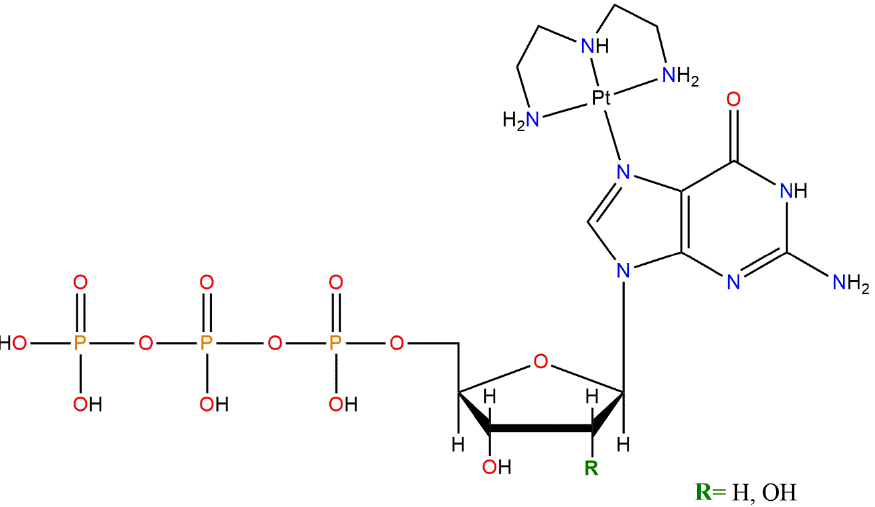
Figure 11. Schematic representation of the [Pt(dien)( N 7- 5′ -GTP)] and [Pt(dien)( N 7- 5′ -dGTP)], with R = OH and H, respectively.